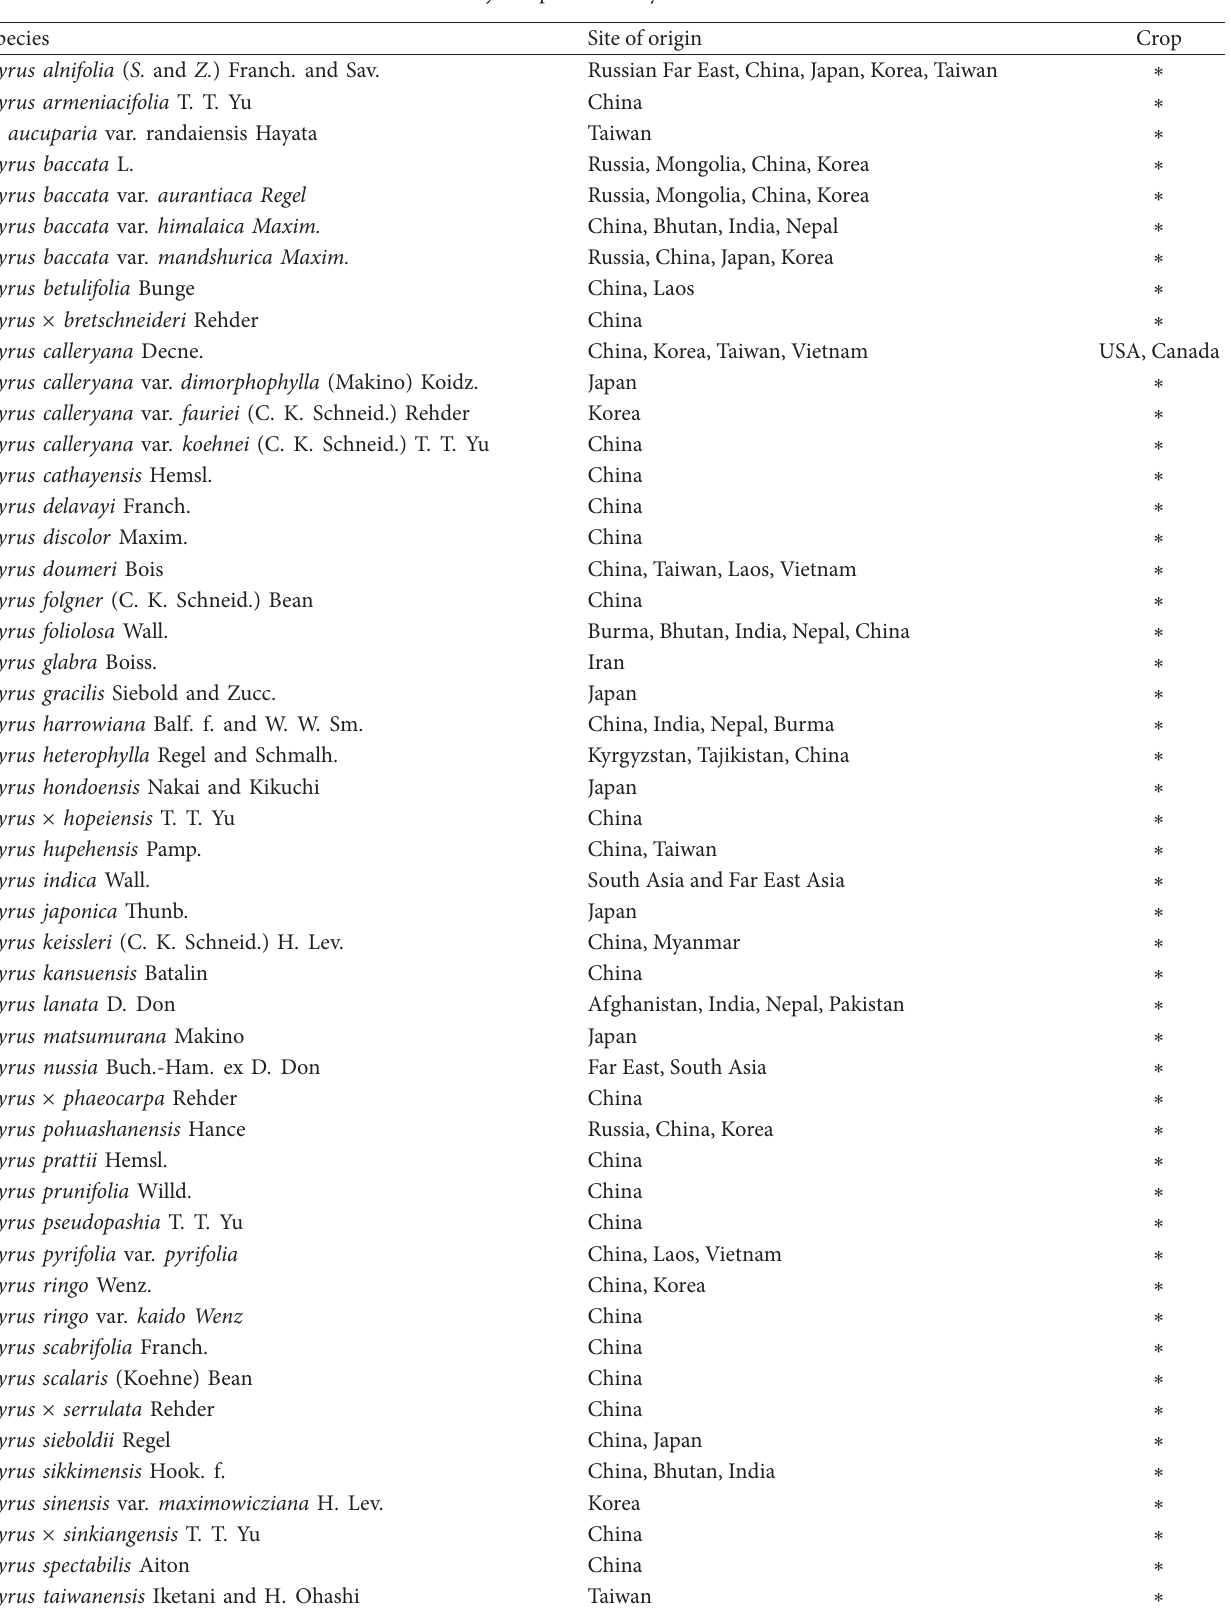
Table 1: Pyrus species and hybrids from